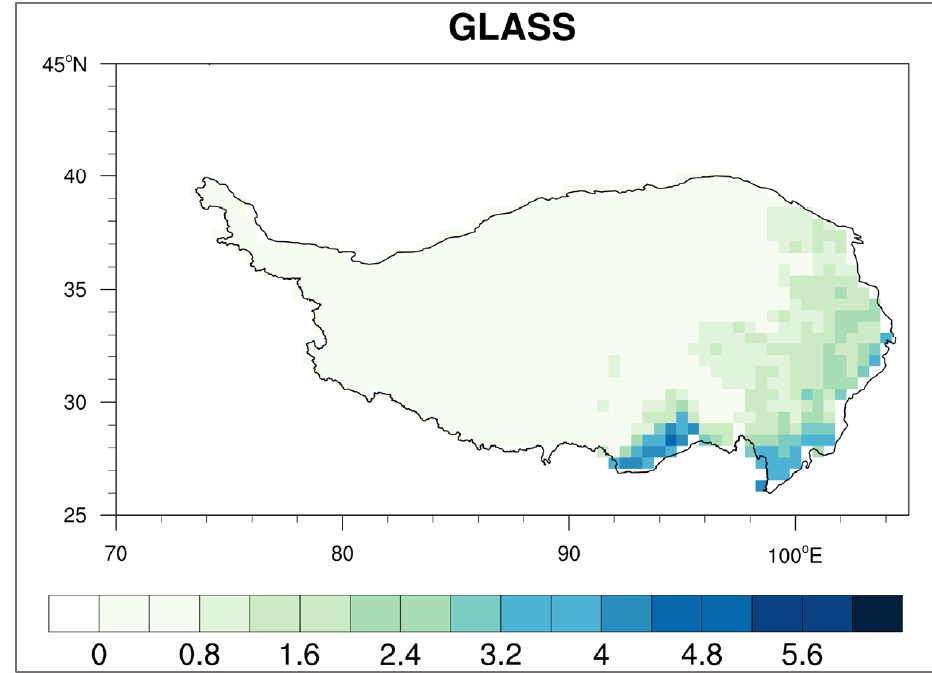
Figure 6. Spatial distribution of the GLASS LAI during the growing season.